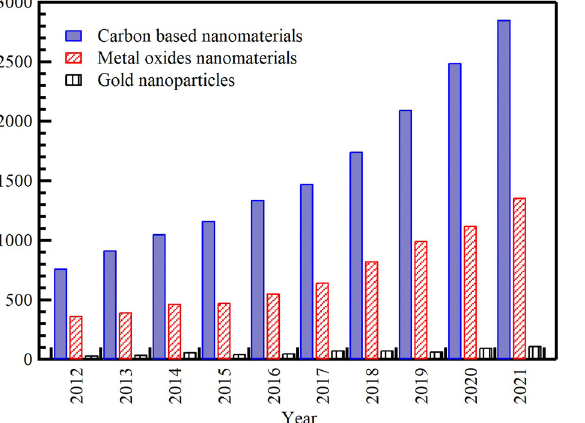
Figure 1: Distribution of the cumulative number of publications on waste - derived NPs per year from the Scopus database ( December 2021 ) according to keywords. Search strategy example: “ waste ” AND ( “ carbon nanomaterials ” OR “ carbon nano fi bers ” OR “ gra - phene ” OR “ activated carbon ” OR “ carbon nanotubes ” ) , metal oxide, gold nanoparticles in the title, abstract, or keywords fi eld.